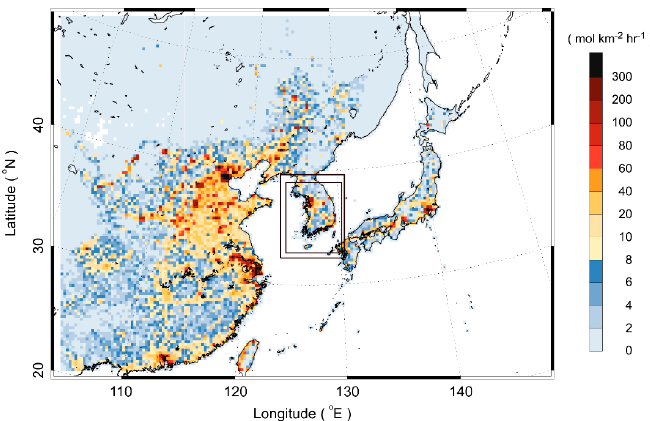
Figure 1. Simulation domains of the Weather Research and Forecast-Chemistry (WRF-Chem) and WRF/Community Multiscale Air Quality (CMAQ) models. The outermost domain has a grid resolution of 27 km and the nested domains denoted by the rectangles have a grid resolution of 9 km and 3 km, respectively. Color-coded are monthly mean anthropogenic NO X emission fluxes for April 2015.